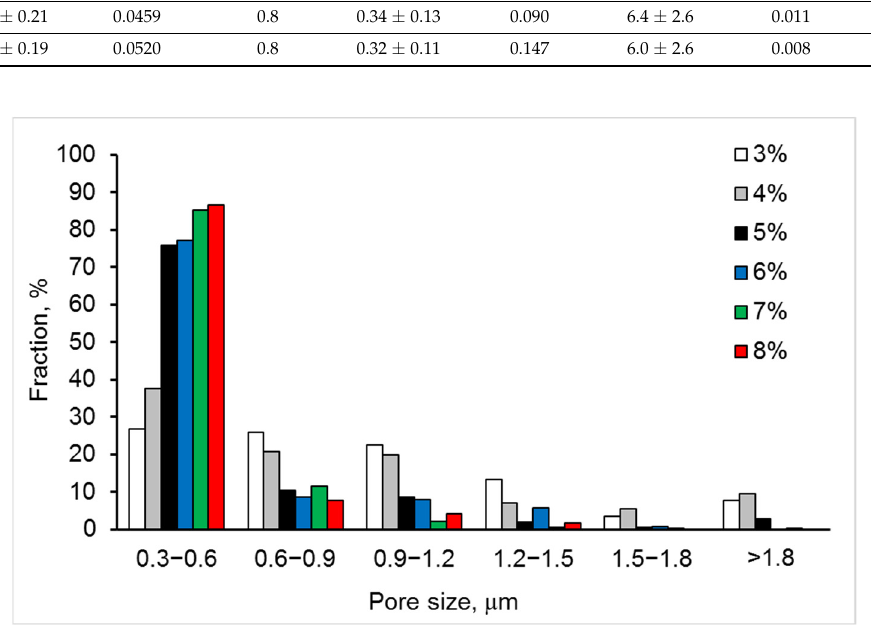
Figure 2. Pore size distributions for six studied materials with 3–8% Y 2 O 3 . Table 1. Average parameters of microstructure and fracture surface. In contrast to the abovementioned cases, when the yttria percentage increases from 6 to 7 mol% (Figure 1d,e), the 0.9–1.2 µ m pore fraction steeply decreases from 7 to 2%, and the 1.2–1.5 µ m pore fraction decreases from 5.5 to 0.5%, while an increase in 0.3–0.6 µ